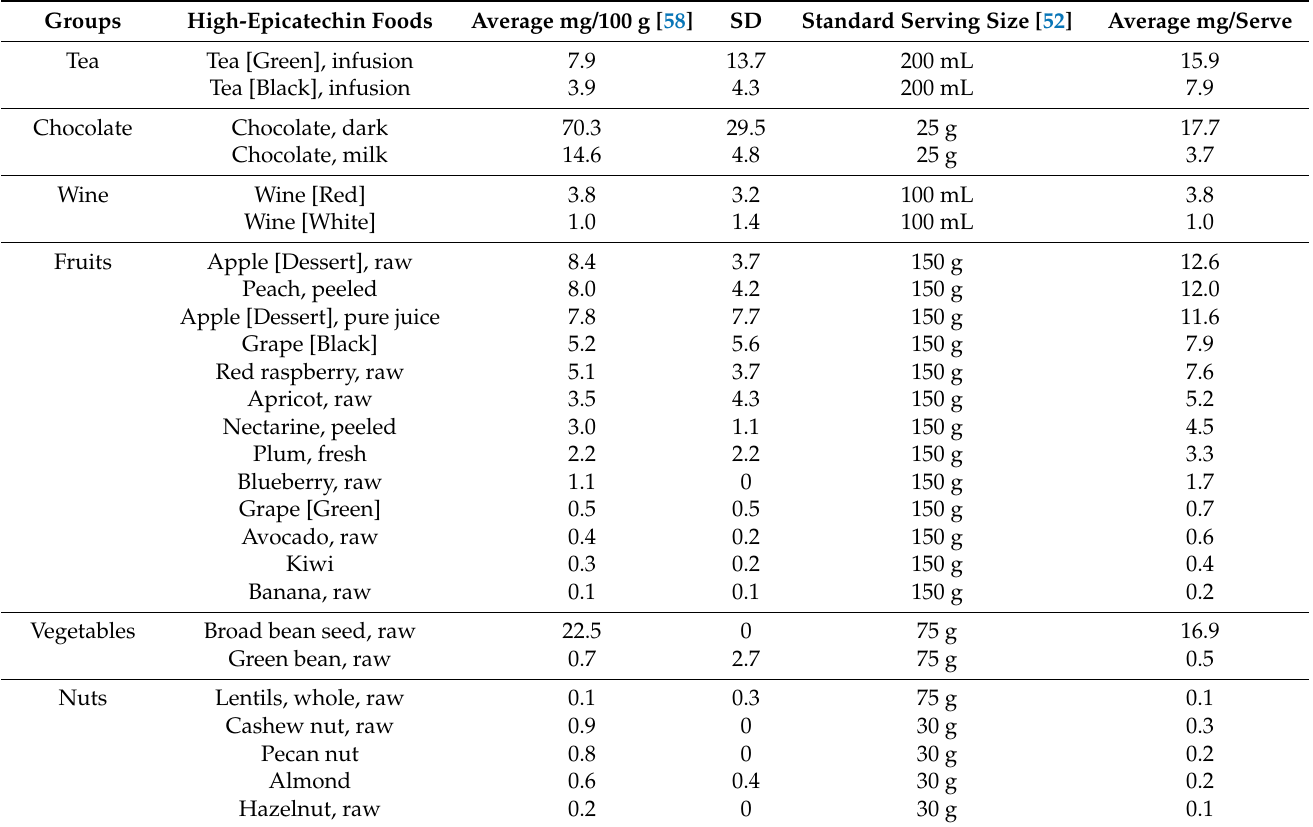
Table 1. Foods with high epicatechin content ( ≥ 0.1 mg/100 g; Phenol